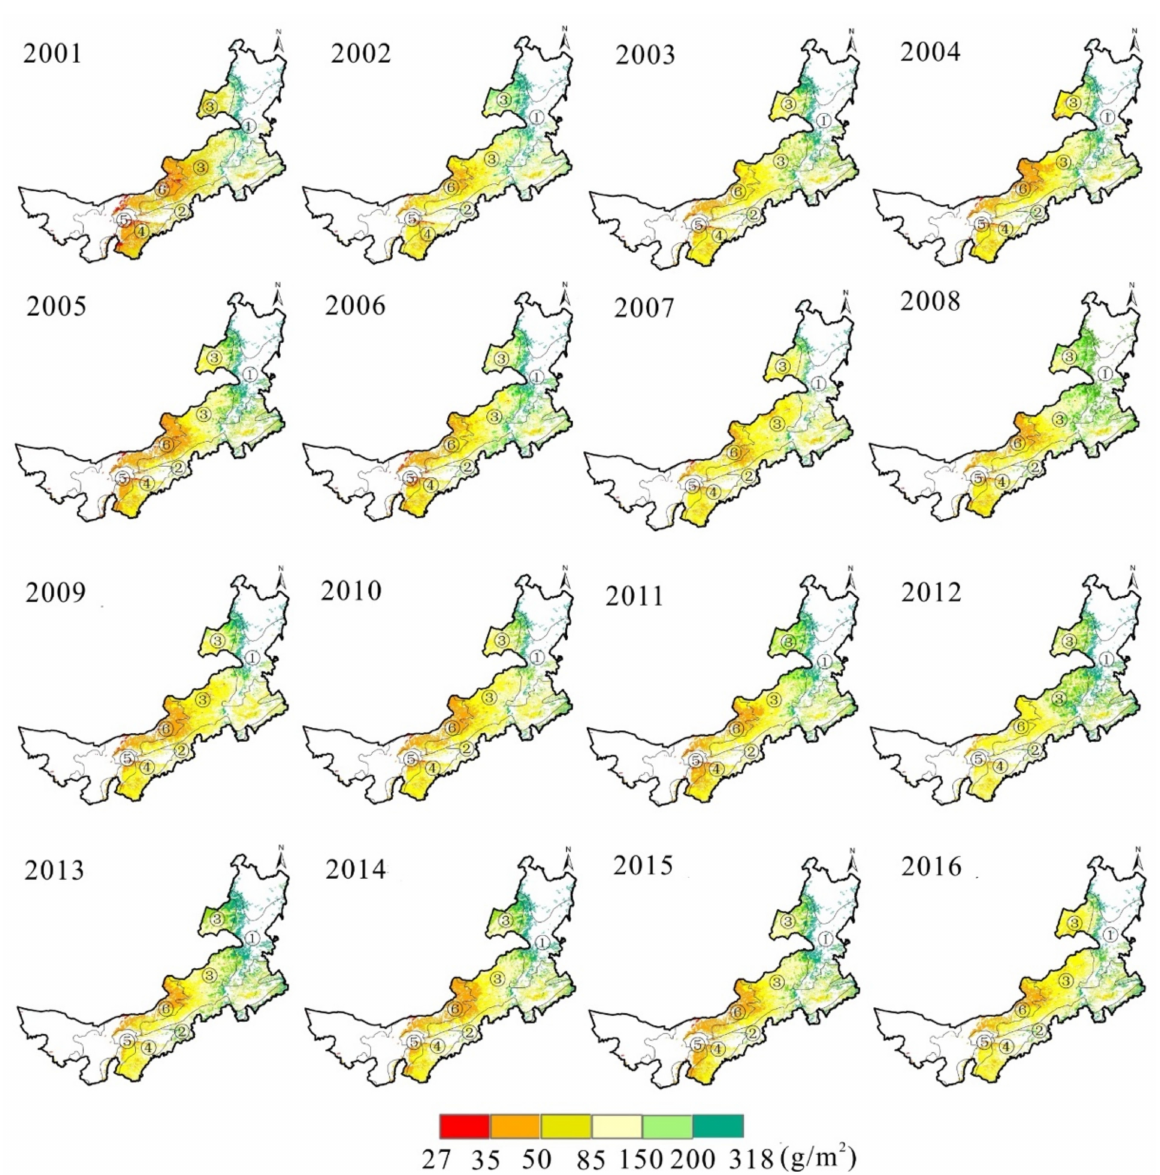
Figure 3. Spatial distribution of combustible load in the grasslands area of Inner Mongolia during the growing season from 2001 to 2016 (Note: 1 (cid:13) – 6 (cid:13) see Figure 1). The area share of various classes of combustible load per unit area in northern tem- perate meadow grasslands, southern temperate desert grasslands, and temperate shrub desert grasslands formed a sharp contrast, with the peak area shares of northern temperate meadow grasslands ranging from 200 to 318 g/m 2 . The peak areas of typical grasslands in the northern temperate zone varied from 85 to 150 g/m 2 , those in the southern temperate zone varied from 50 to 85 g/m 2 , and those in the southern temperate zone for desert grasslands and temperate shrub desert grasslands varied from 35 to 50 g/m 2 (Figure